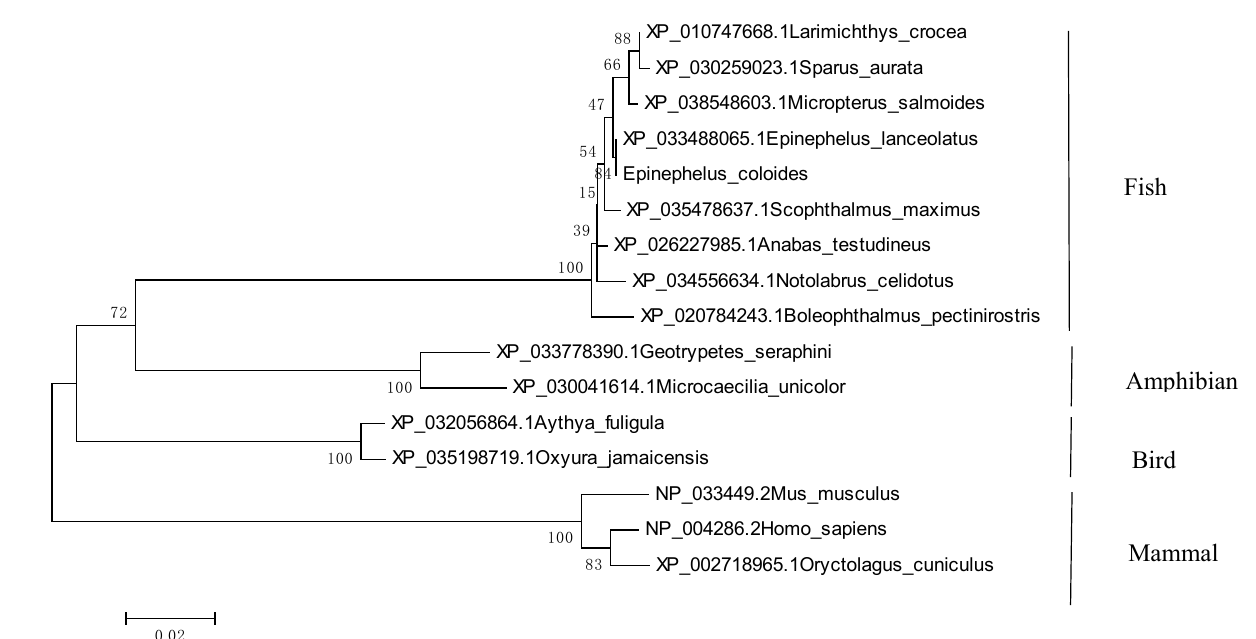
Figure 2. Phylogenetic analysis of the EcTRAF4 proteins. The GenBank accession number for each species is listed to the left of the species name. The phylogenetic tree was constructed using MEGA software 4.0. The relationships among the various components were analyzed by the neighbor-joining (NJ) method. Numbers on the branches indicate percent bootstrap confidence values from 1000 replicates.